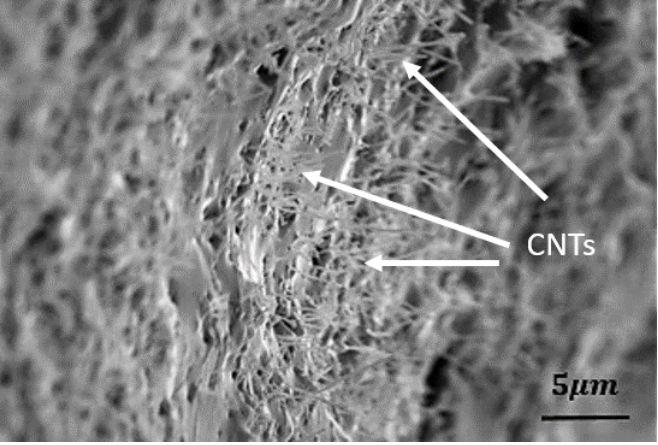
Figure 3. ( a ) SEM image of a partial cross-sectional area of a stacked DEA sample with an average of 50 µ m layer thickness. ( b ) A different cross-sectional area of the same stacked actuator modified in ImageJ to highlight the MWCNT distribution in the actuator. Image from [19].